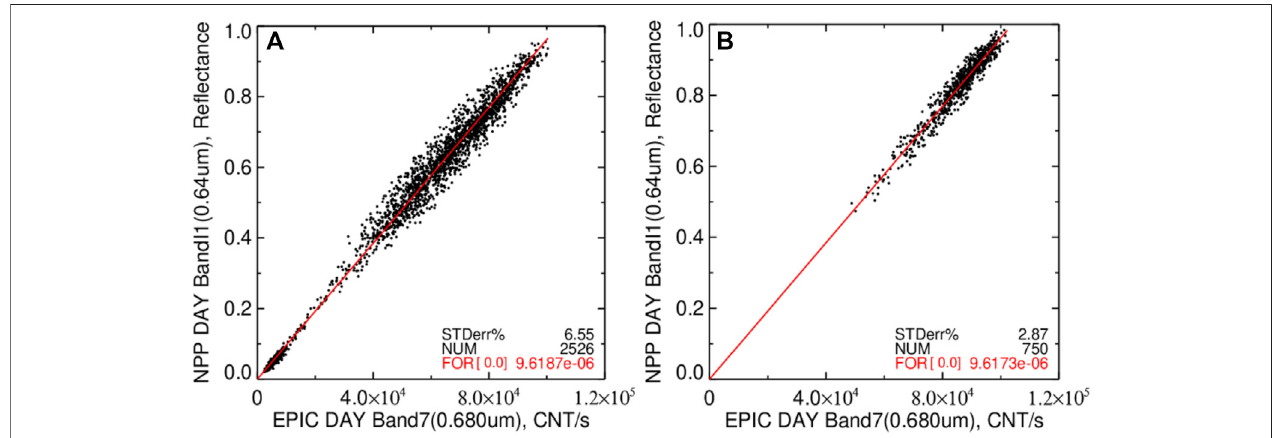
FIGURE 1 | The (A) ATO-RM and (B) DCC-RM E-7 count and V NPP -I1 re fl ectance pair scatter plots for May 2020 with associated linear regression (solid red line). The number of pairs ( NUM ), standard error ( STDerr% ), and linear regression slope through an offset of 0 ( FOR ) in count − 1 or gain ( Eq. 1 ) is given in the lower right.